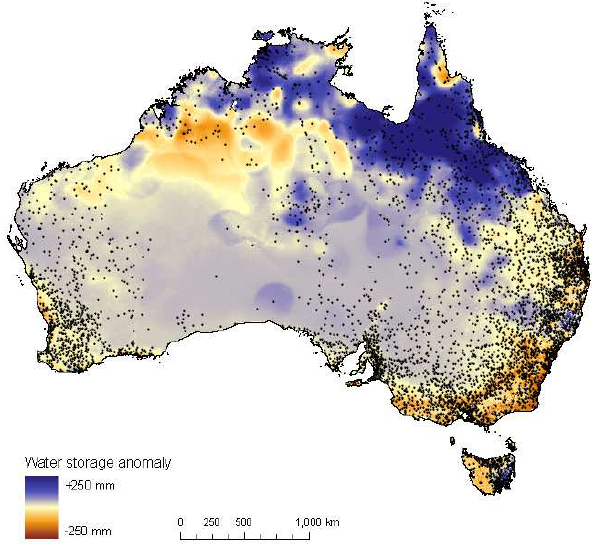
Fig. 2. Total water storage anomaly map for 1 February 2010, in- cluding water in the vegetation, soil, ground water and surface stor- Figure 2. Total water storage anomaly map for 1 February 2010, including water in the ages. Anomalies are calculated with reference to the average for the same day in the years 1980–2009. Points indicate the location vegetation, soil, ground water and surface storages. Anomalies are calculated with reference of rain gauges used in the derivation of the interpolated model forc- to the average for the same day in the years 1980-2009. Points indicate the location of rain gauges used in the derivation of the interpolated model forcing.